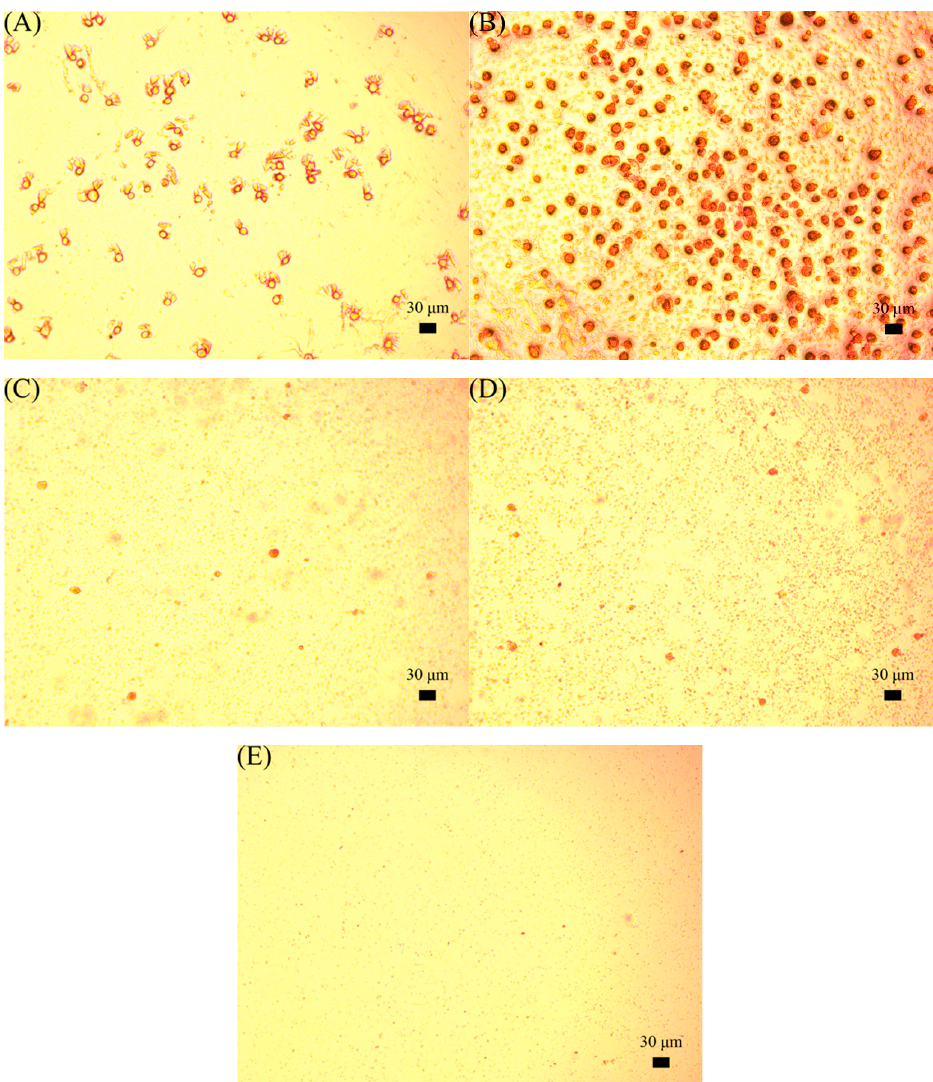
Figure 7. Images of HEK-293T cells grown on ITO ( A ), P4 ( B ), CP20 ( C ), CP40 ( D ), and CP60 ( E ) polymer surfaces, scale bar = 30 μ m.